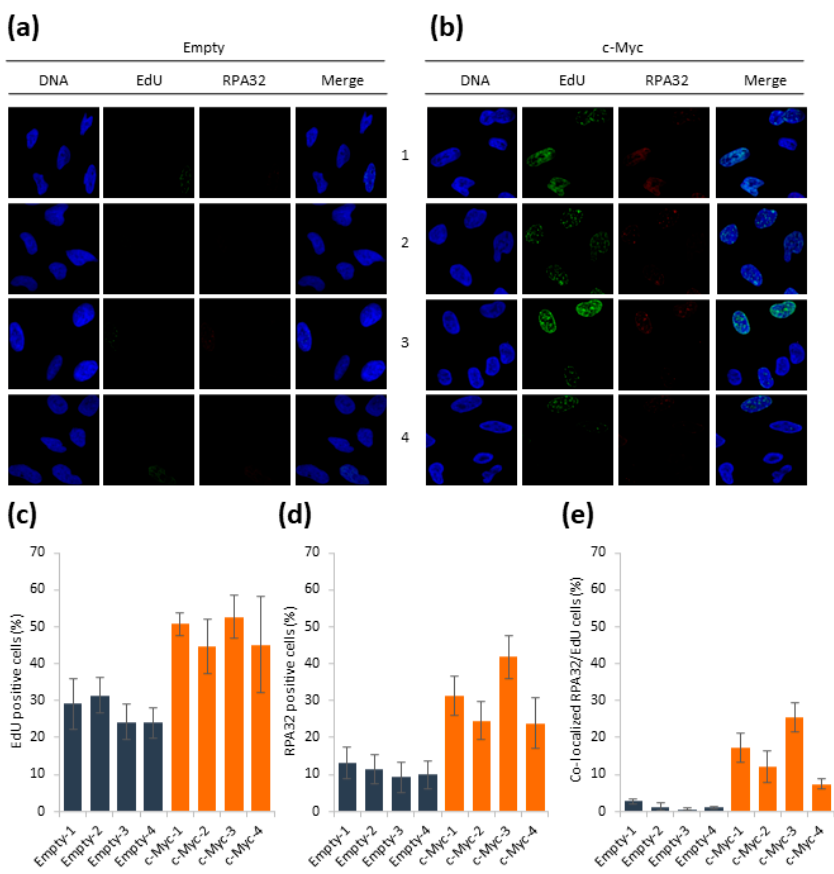
Figure 2. Increased EdU incorporation and RPA32 foci in c-Myc overexpressing HA1EB cells. ( a , b ) HA1EB cells were labeled with EdU for 15 min and stained with EdU Click-iT (according to the manufacturer’s instructions) and anti-RPA32 antibody. DNA was stained using DAPI. Images were taken using a Zeiss LSM-780 confocal microscope and analyzed using Image J software. A total of 150 cells/sample was counted, n = 3 ± S.E.M. ( c ) Quantification of EdU incorporation. Mean intensity ≥ 5 AU was considered as positive. ( d ) Percentage of cells with ≥ 5 RPA32 foci. ( e ) Percentage of cells with ≥ 5 RPA32/EdU co-localized foci.